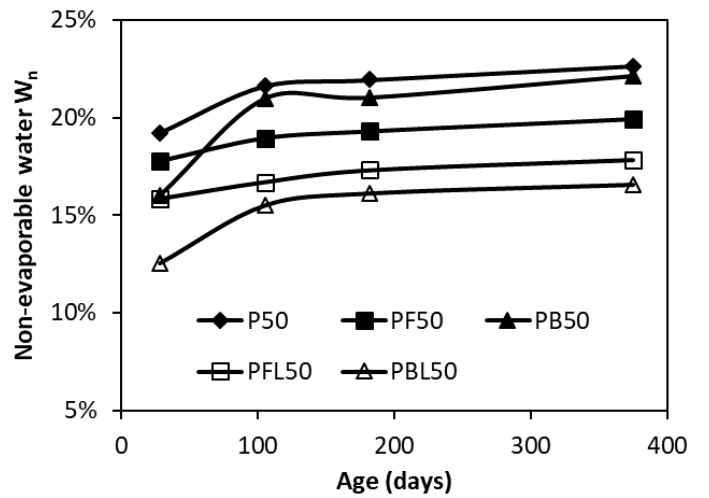
Figure 11. Evolution of non-evaporable water with age in various cementitious pastes.